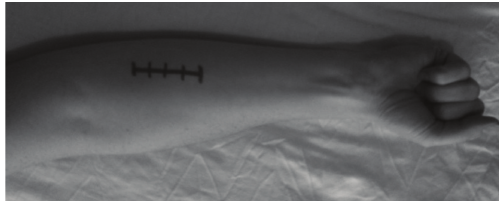
Figure 2: An incision was made just ulnar to the midline on the volar aspect of the